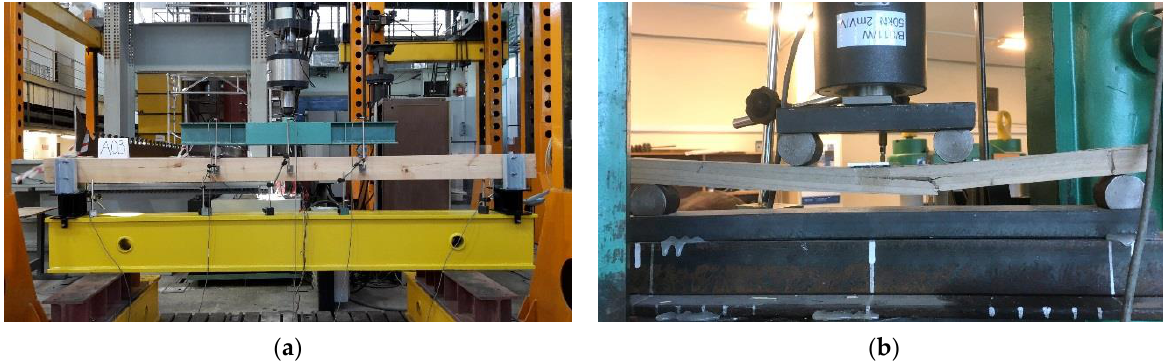
Figure 4. View of experimental stands for testing: ( a ) technical scale beam, ( b ) small clear specimen (Group 2).